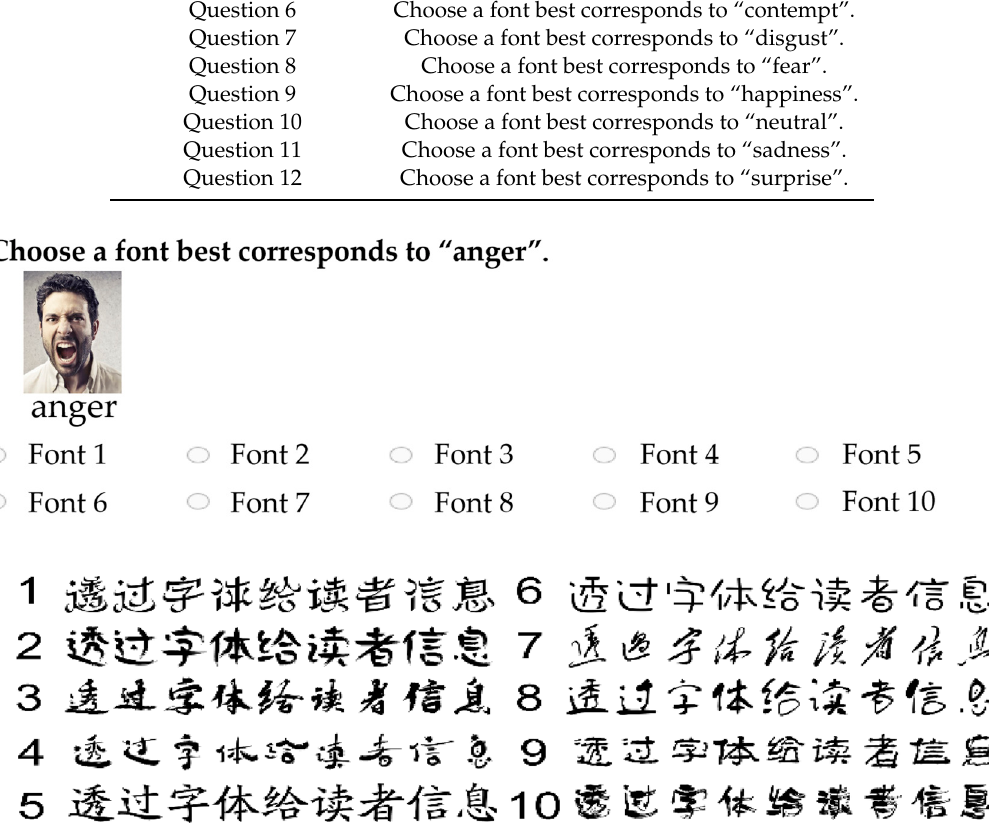
Figure 2. A typical example of the questionnaire, which asking respondents to choose a font that corresponds to the emotion shown in the facial image (The emotion “anger” is shown here). Table 1. Questions 1–4 aim to acquire basic information of respondents, which is useful to improve the credibility of questionnaire. Questions 5–12 are main content of questionnaire.